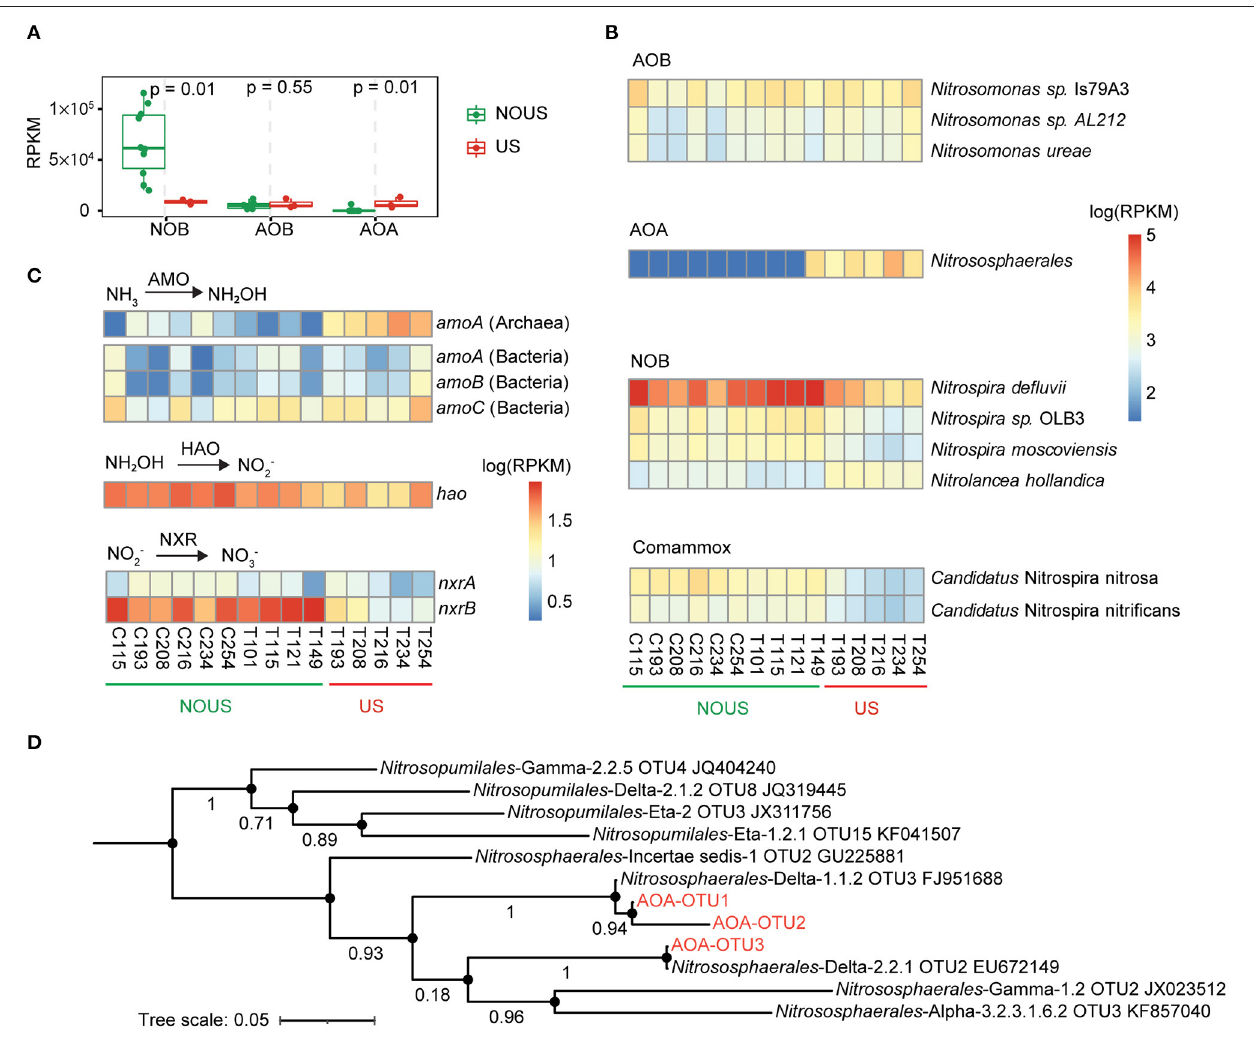
FIGURE 2 | Microbes and genes involved in nitrification. (A) Comparison of NOB, AOB and AOA using Wilcoxon test. (B) Abundance variation of microorganisms involved in nitrification. The abundance of genes and microbes was scaled as reads per kilobase per million mapped reads (RPKM). (C) Changes in the abundance of genes encoding enzymes involved in nitrification, including ammonia monooxygenase (AMO), hydroxylamine oxidoreductase (HAO) and nitrite oxidoreductase (NXR). (D) Phylogenetic tree of archaeal amoA gene. Three archaeal amoA genes found in this study were aligned with 1,190 near-full-length (591–594 bp) archaeal amoA genes collected from pure culture and environmental enrichment to a build phylogenetic tree, of which nearest OTUs were selected to plot the above